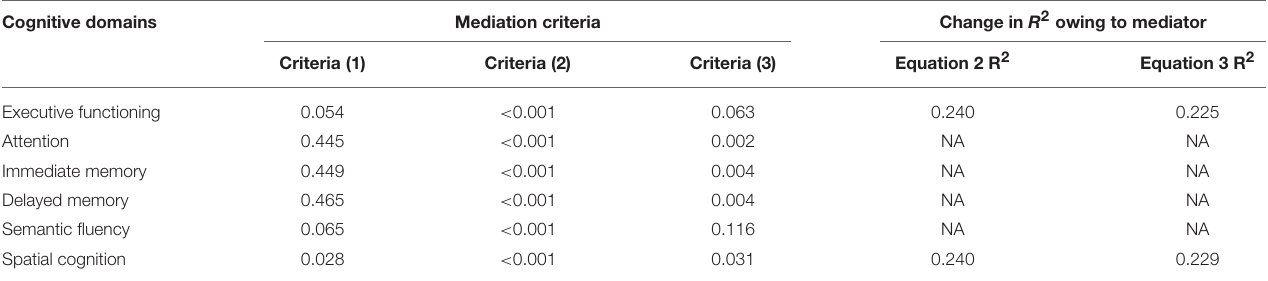
TABLE 2 | P- values for mediation criteria, and R 2 values, of the MDD status-FAST total relationship as mediated by composite cognitive domains ( N = 155). Cognitive domains